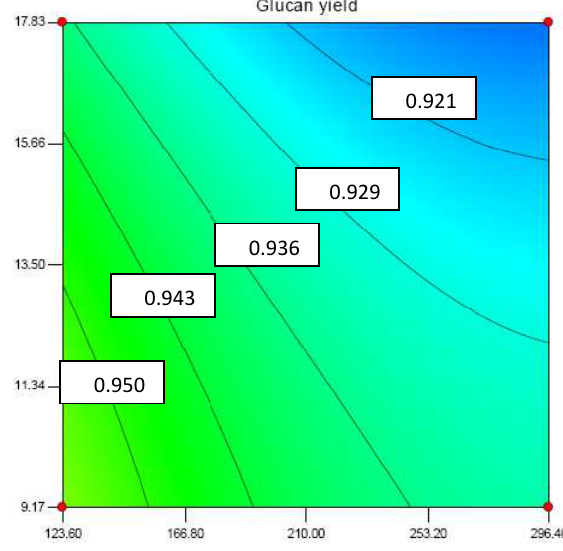
Fig. 3-C.X: time (min), Y: Pressure (bar), temperature 147 0